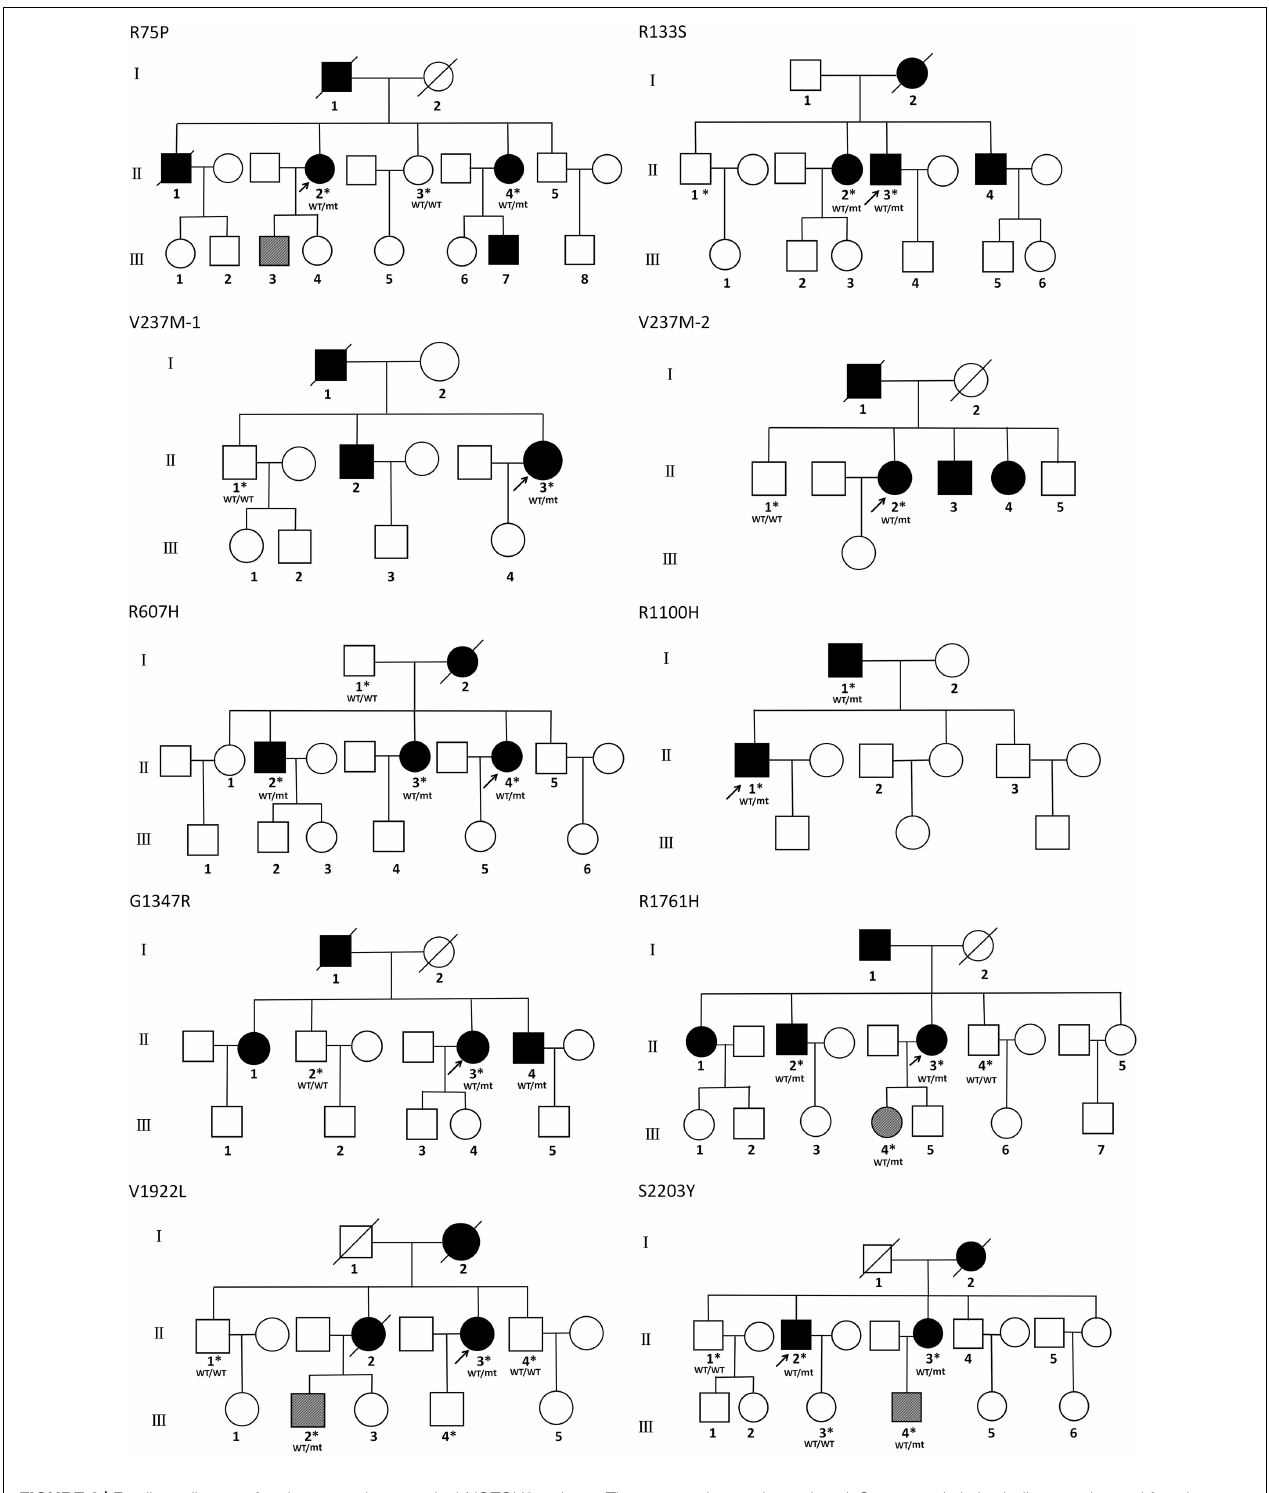
FIGURE 2 | Family pedigrees of patients carrying untypical NOTCH3 variants. The arrow points to the proband. Square and circles indicate males and females, respectively. A bar across the symbol means a decreased individual. Symptomatic family members are shown in black filled. Asymptomatic family members with MRI abnormalities are shown in stripe filled. Asterisks indicate gene-tested subjects. WT, wide type; mt, mutant variant.